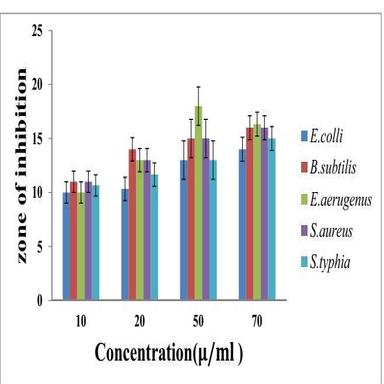
Comparative zone of inhibition against different bacteria.